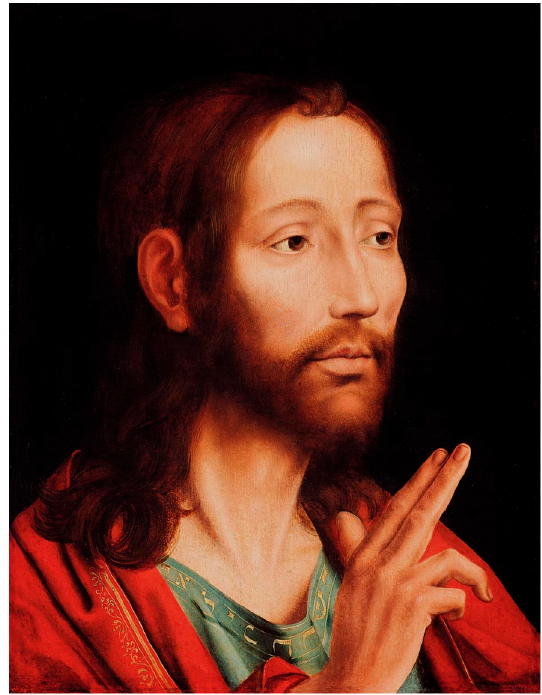
Figure 9. Quentin Massys? Jan Massys? Christ blessing , 1528–38. Winterthur, Kunstmuseum Winterthur. Courtesy of the Kunstmuseum